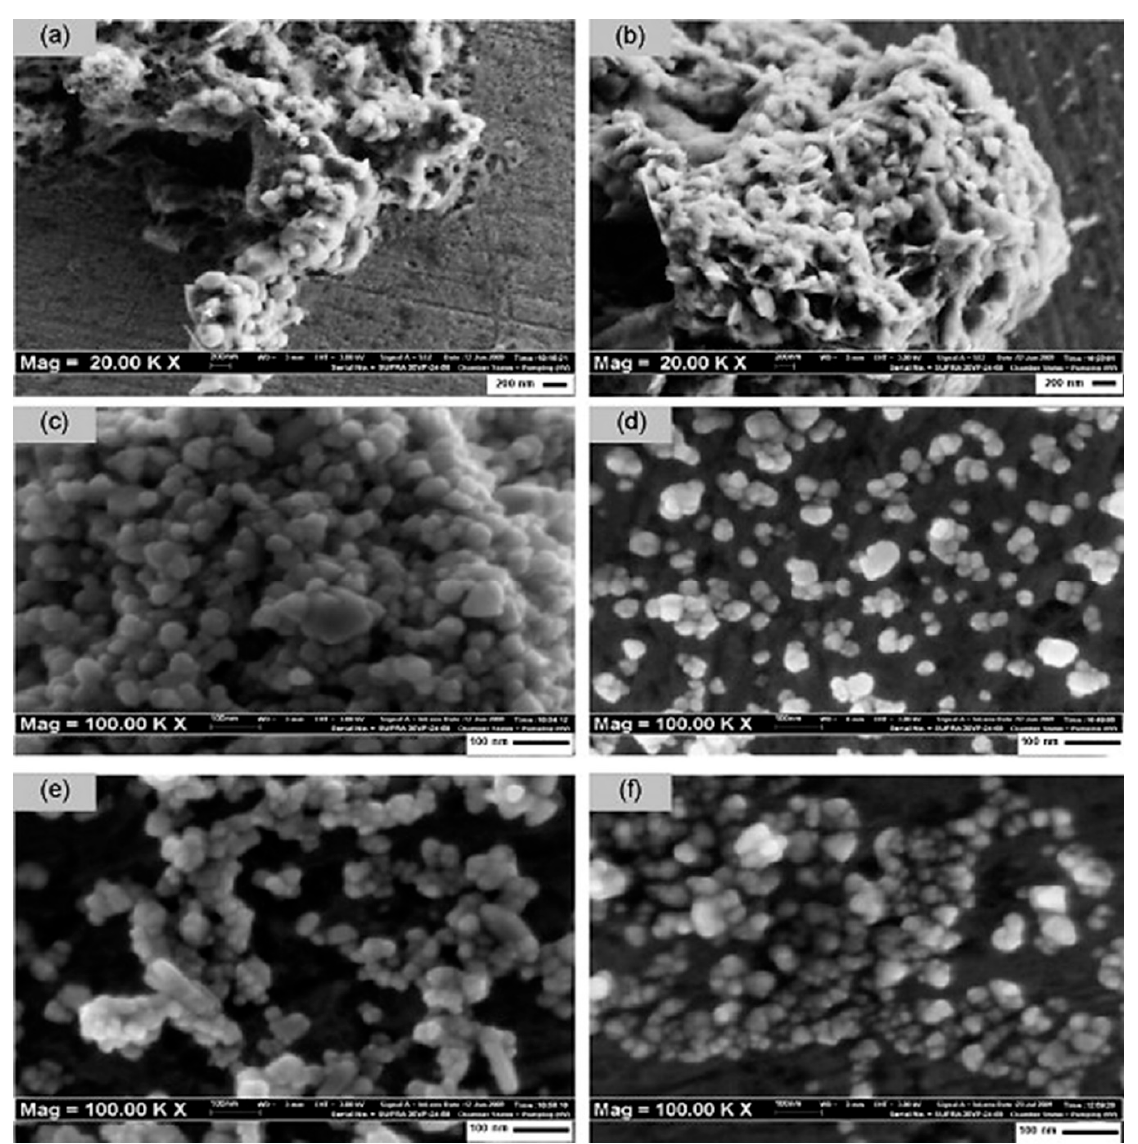
Figure 8. ( a – f ) FESEM analysis of sol-gel synthesised nZnO at varies pH from 6 to 11, respectively. Reprinted with permission from Reference [65]. Copyright 2010, with permission from Elsevier.